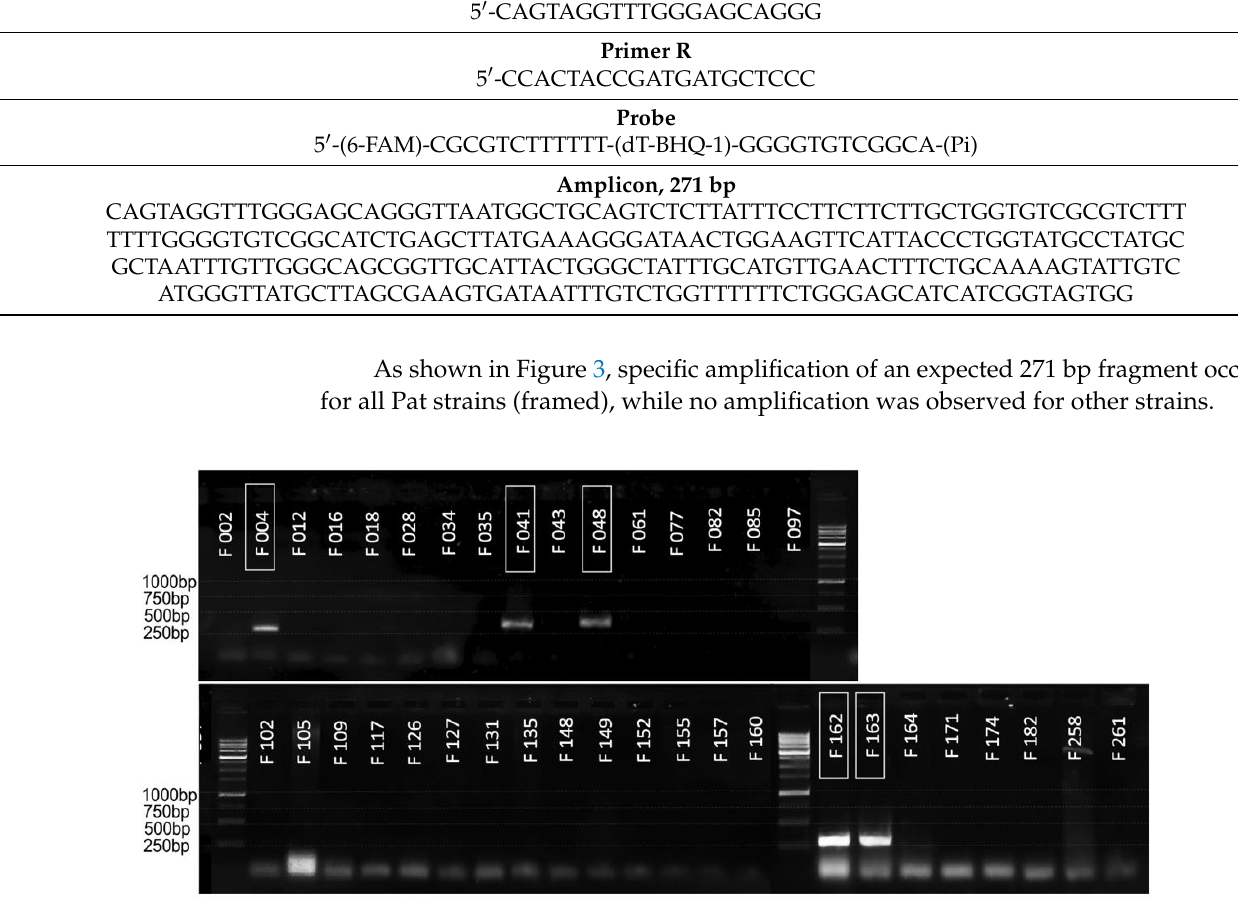
Figure 3. Specificity of the conventional PCR. P. atrosepticum strains are framed. “1 kb DNA Ladder” (Evrogen) was used to assess the amplicon size.